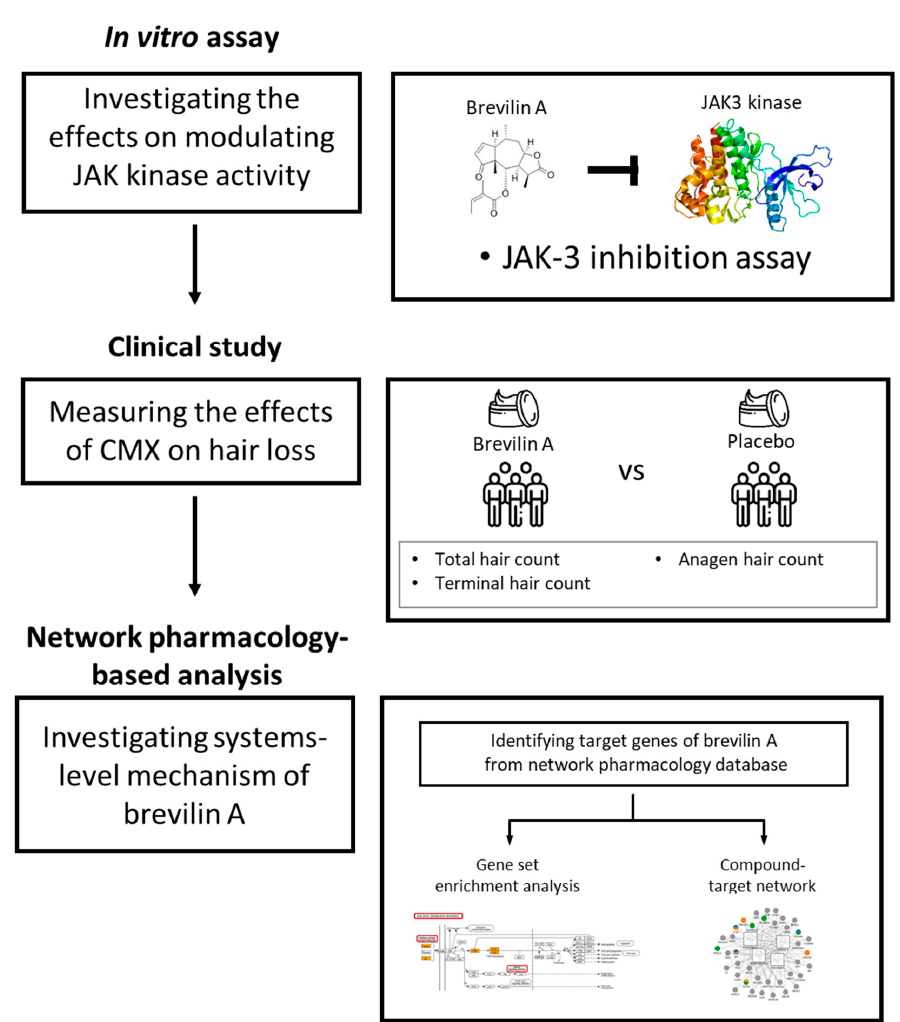
Figure 1. Overview of the study process combined with the clinical study and network pharmacology-based analysis. CMX, emulsion extract of brevilin A from Centipeda minima ; JAK, Janus